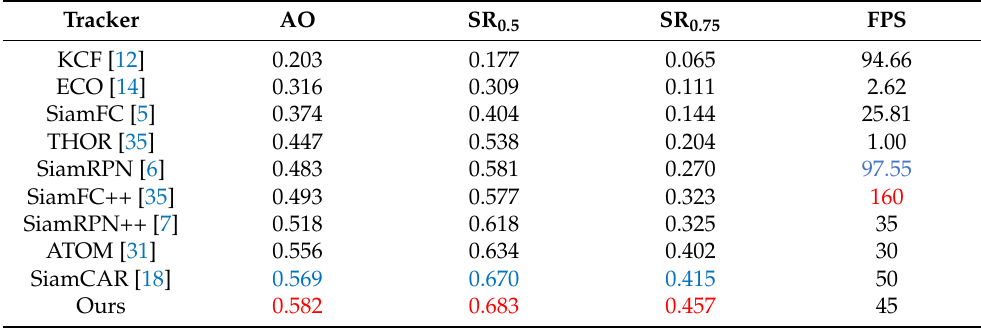
Table 2. The evaluation on GOT-10K.TOP-2 results are highlighted in red and blue, respectively.